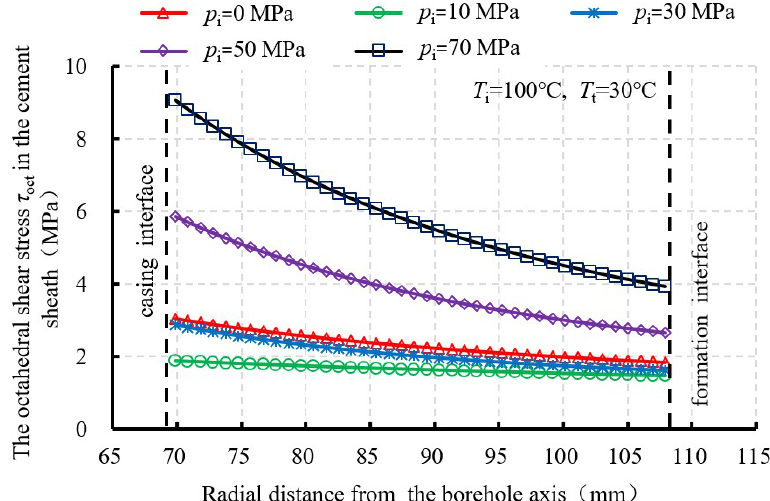
Figure 11. Radial distribution of the octahedral shear stress τ oct in the cement sheath under different increased casing pressures p i and a decreased temperature of 70 °C at the casing inner wall.